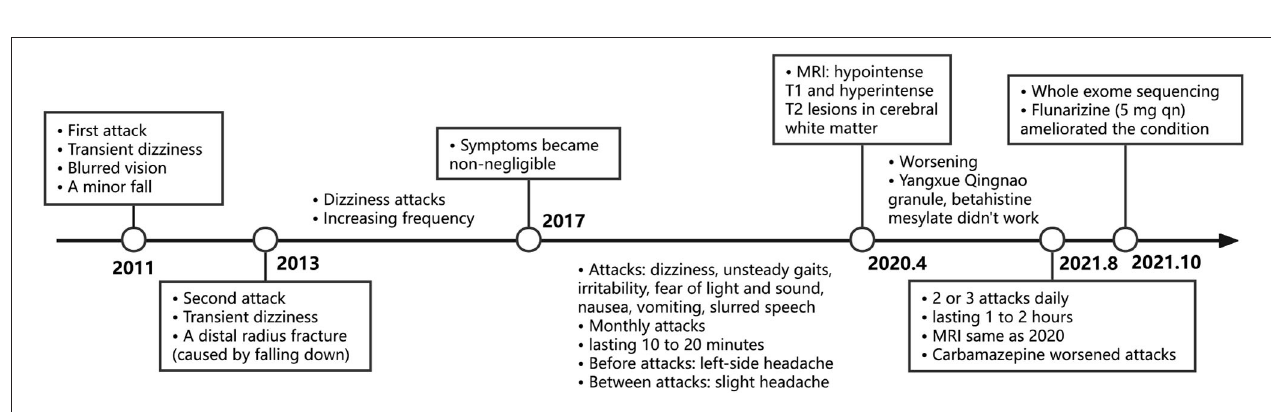
FIGURE 2 | Sanger sequencing of the patient and her healthy parents. No mutation was detected in the parents at the same locus of the patient’s pathogenic variant.